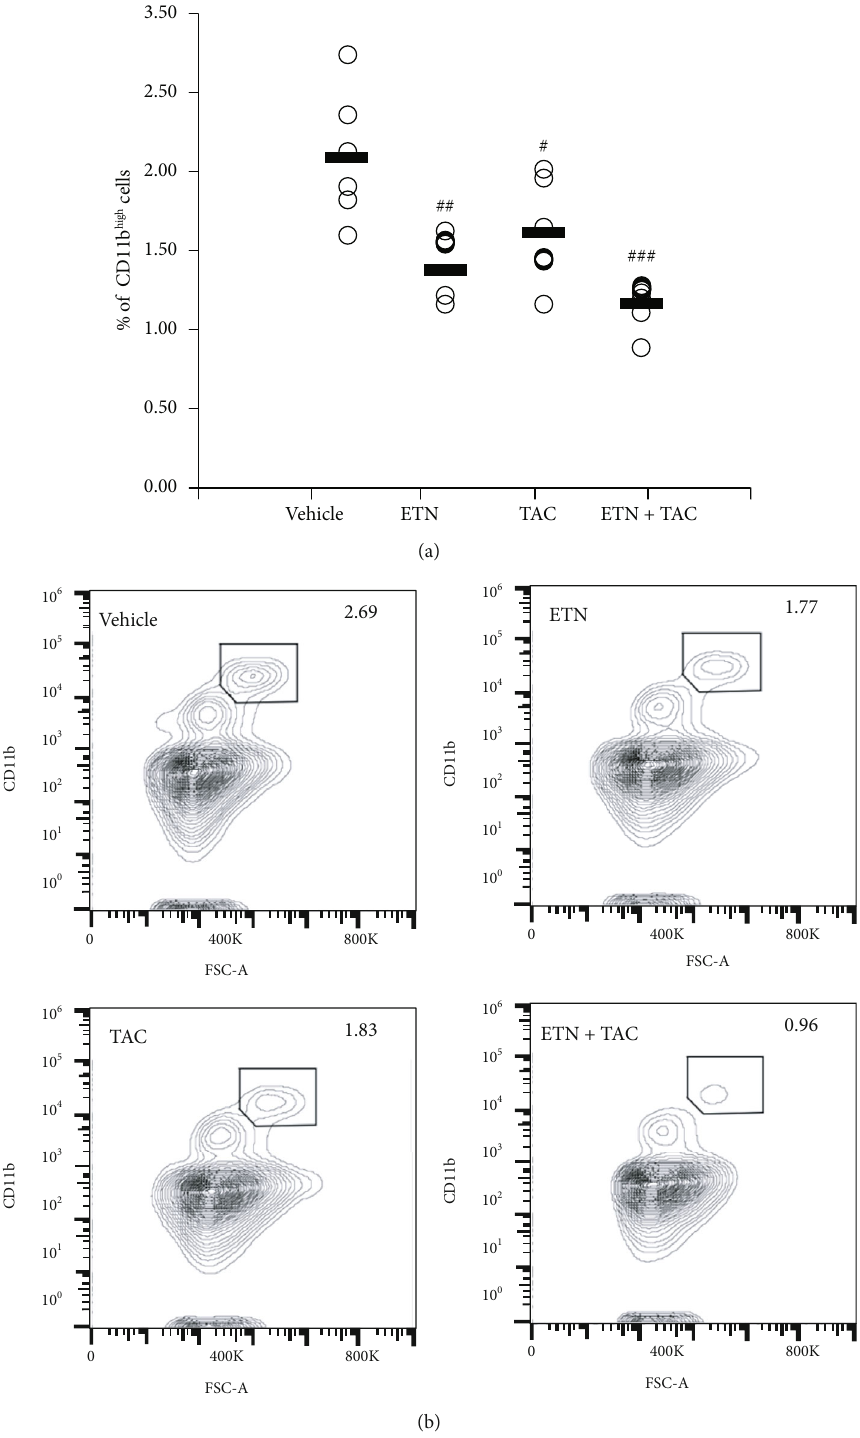
Figure 4: Etanercept and tacrolimus decrease the population of CD11b high peripheral osteoclast precursors in hTNF-Tg mice. Etanercept (ETN; 4 mg/kg) was administered subcutaneously twice a week for 4 weeks, and tacrolimus (TAC; 3 mg/kg) was administered orally once daily for 4 weeks. (a) Percentages of ZombieNIR-negative CD11b high cells in splenic cells derived from individual mice are shown. Each horizontal bar shows the mean of six animals per group. # p < 0 : 05 , ## p < 0 : 01 , and ### p < 0 : 001 compared with the vehicle group (Dunnet ’ s multiple comparison test). $ p < 0 : 05 compared with the tacrolimus-treated group (Student ’ s t -test). (b) Representative plots of each drug treatment group are shown. Data are representative of two independent